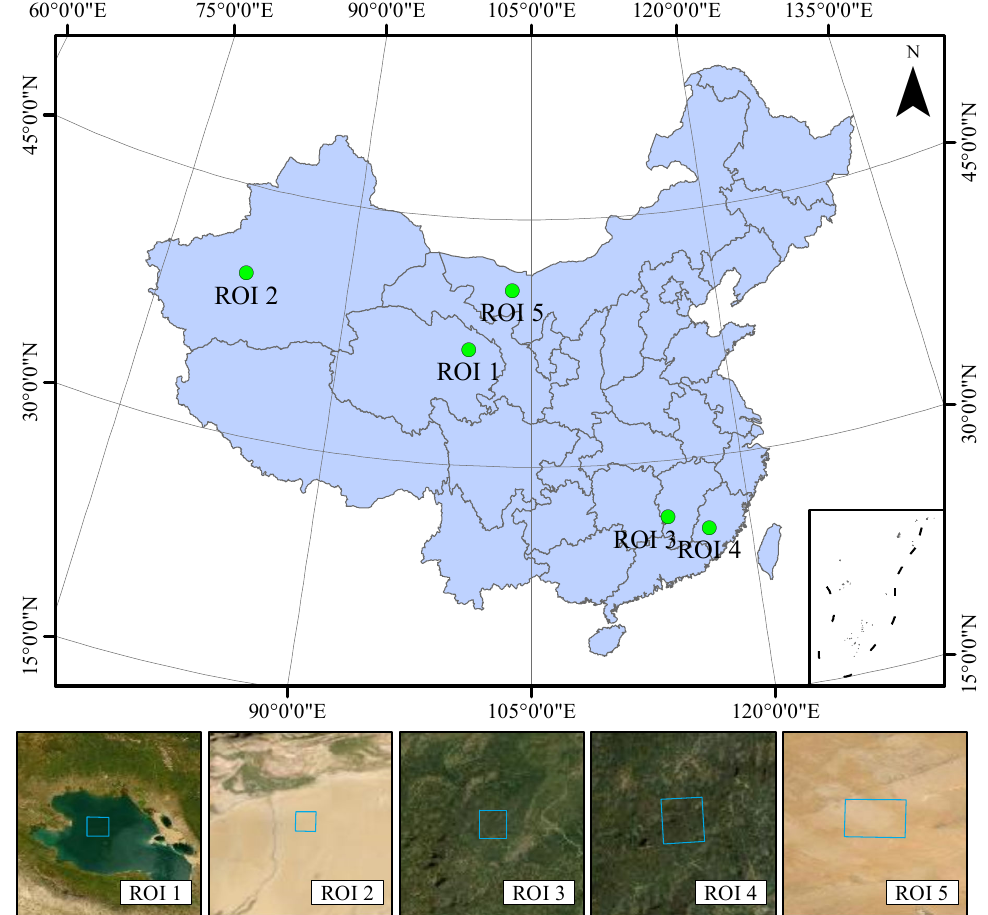
Figure 10. ROIs of spectral-stable land cover in